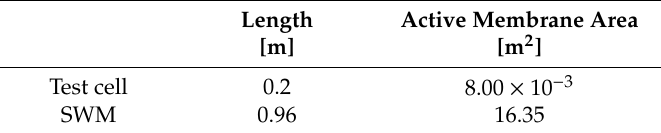
Table 1 sums up the geometrical properties of the SWM and the test cell. Table 1. Geometrical properties of the SWM and the test cell.